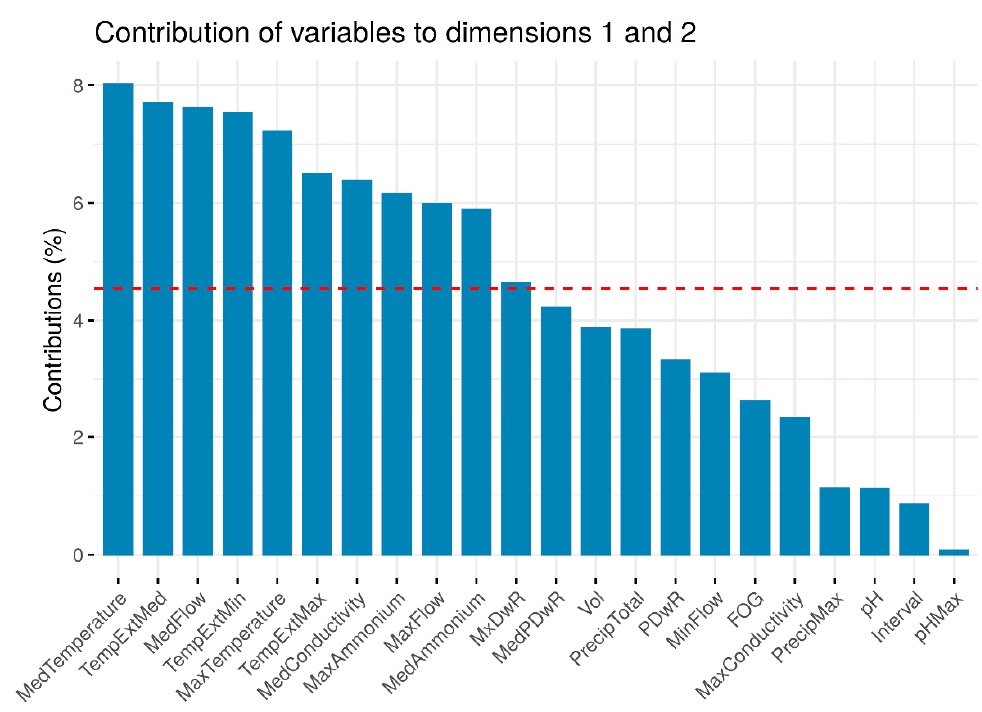
Figure 4. Contribution of variables to Dimensions 1 and